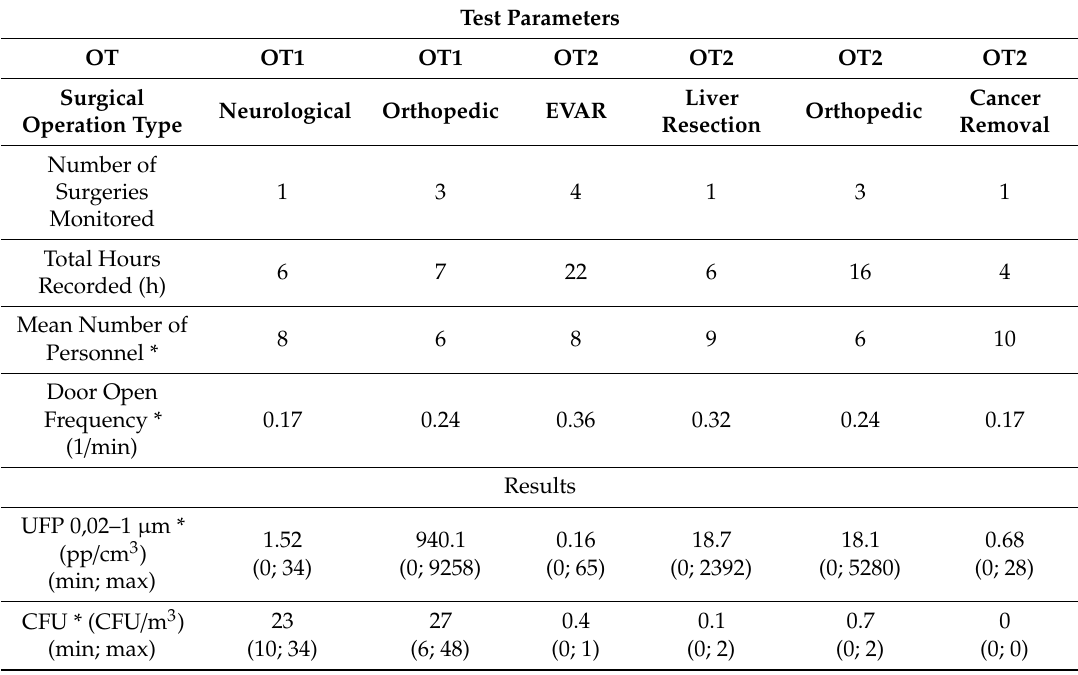
Table 2. Parameters and results of the experimental